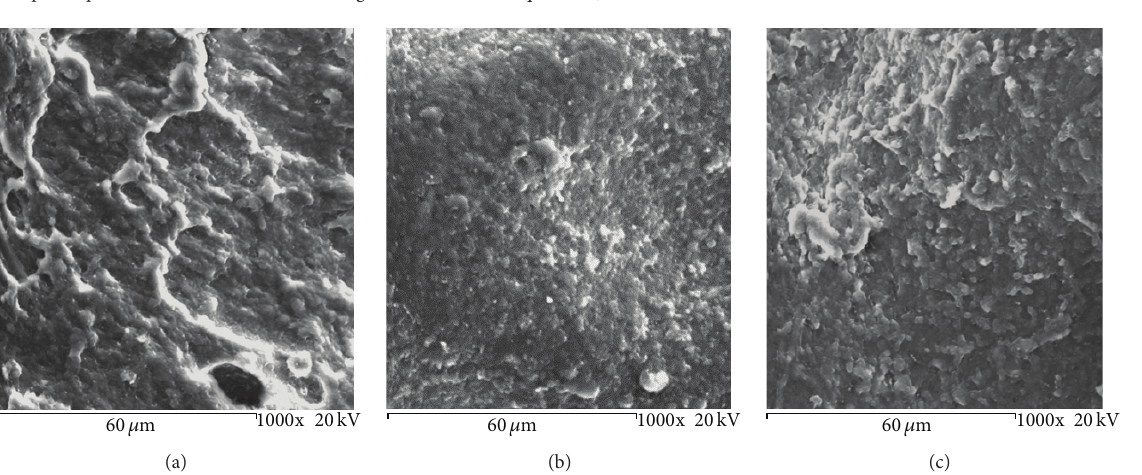
Figure 7: SEM micrographs obtained of gels from giant squid ( Dosidicus gigas ) added with BPP. (a) Gel control (0% BPP), (b) gel with 1% BPP, and (c) gel with 2%